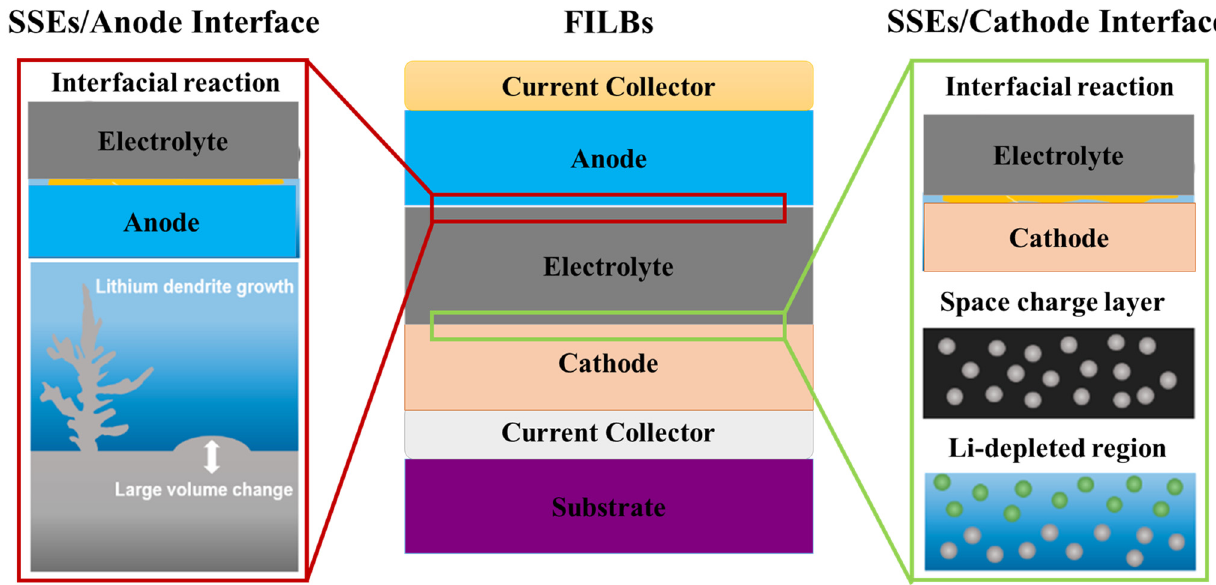
Figure 2. Schematic diagram of TFLIBs and electrode/SSEs interface issues [21].